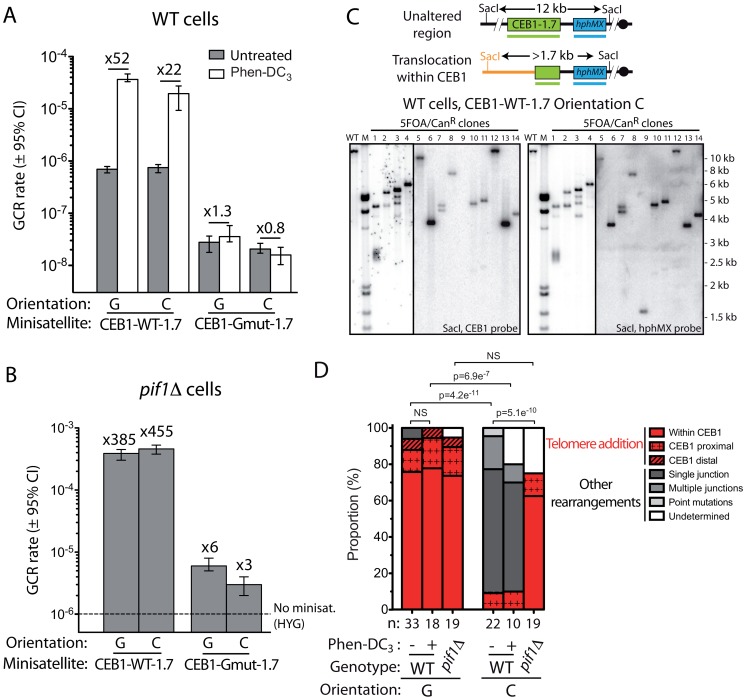
The nature of the GCR, but not the GCR rate, depends on the orientation of CEB1 in WT cells.(A) GCR rates in untreated (grey) and Phen-DC3-treated (white) WT cells bearing CEB1-WT-1.7 in the orientation G (ORT6542-6) and C (ORT6591-1), and CEB1-Gmut-1.7 in the orientation G (ORT6550-2) and C (ORT6548). The fold increases of the GCR rate upon treatment with Phen-DC3 is indicated. (B) GCR rates in pif1Δ cells bearing CEB1-WT-1.7 in the orientation G (ORT6543-1) and C (ORT7153-9), and CEB1-Gmut-1.7 in the orientation G (ORT6551-1) and C (ORT6549). The dotted line indicates the GCR rate in the “no minisatellite” control pif1Δ strain (ORT6568) (see Figure 1D). Other legends as in Figure 1D. (C) The top panel schematically represents the genomic region surrounding CEB1 with the SacI restriction site and CEB1 (green) and hphMX (blue) probes used to study rearrangements of the region. The size of the unaltered region upon digestion is indicated. The example of a translocation within CEB1 is shown, and is expected to produce a fragment longer than 1.7 kb. The bottom panels show the rearrangements present in 14 5FOA/Can-resistant clones obtained from independent cultures of WT cells bearing CEB1-WT-1.7 in the orientation C, and in the parental 5FOA/Can-sensitive strain (WT, ORT6591-1). In most lanes the bands hybridized both the CEB1 and the hphMX probes, except in clone 9 in which CEB1 has been lost. M = Size marker. (D) Nature of the GCR determined by Southern blot analysis of independent 5FOA/Can-resistant colonies derived of cells bearing CEB1-WT-1.7 in the orientations G or C, in WT cells treated or not with Phen-DC3 10 µM, or in pif1Δ cells. The results are presented as a percentage of the total number (n) of 5FOA/Can-resistant colonies analyzed. Telomere additions are shown in red, and their locations relative to CEB1 are indicated by different motifs: within CEB1 (no motif), in proximal (cross), or in distal (lines) position to CEB1. Other rearrangements that appear as discrete bands on the Southern blots are shown in grey: single junction (only one band) and multiple junctions (more than one band) are shown in dark grey and grey, respectively. The strain point mutated for URA3 and CAN1 (point mutations) is shown in light grey. In some instances, colonies have lost both CEB1 and hphMX and the junction has not been determined (Undetermined, white): this may correspond to telomere additions or other rearrangements in the 8.3 kb region between hphMX and the first essential gene (PCM1). Distributions were compared using the Fisher's exact test.